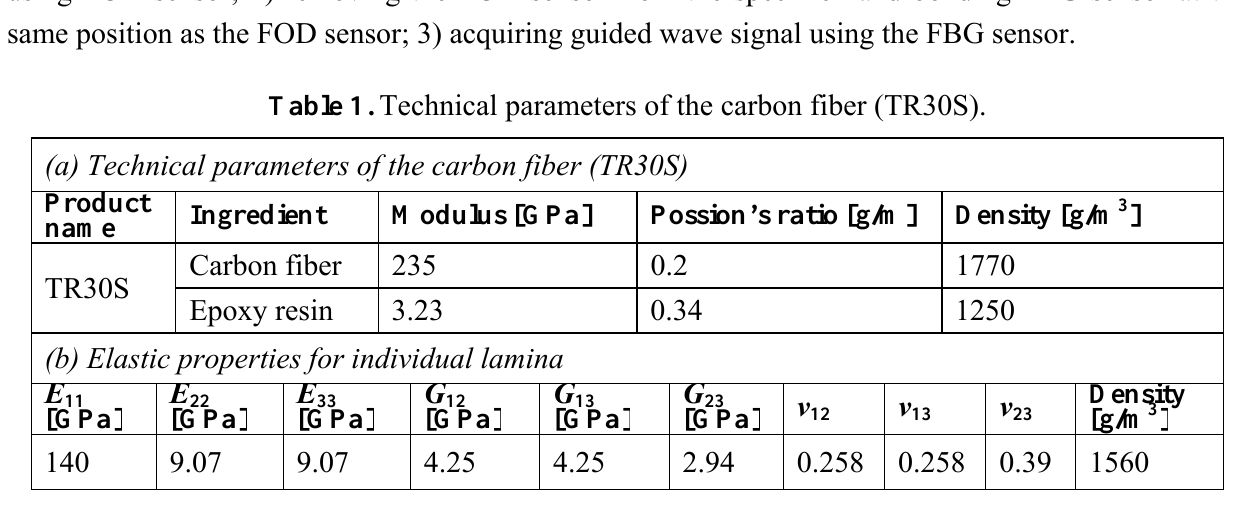
Figure 5. (a) Sketch of the quasi-isotropic CFRP laminate. (b) Picture of a CFRP